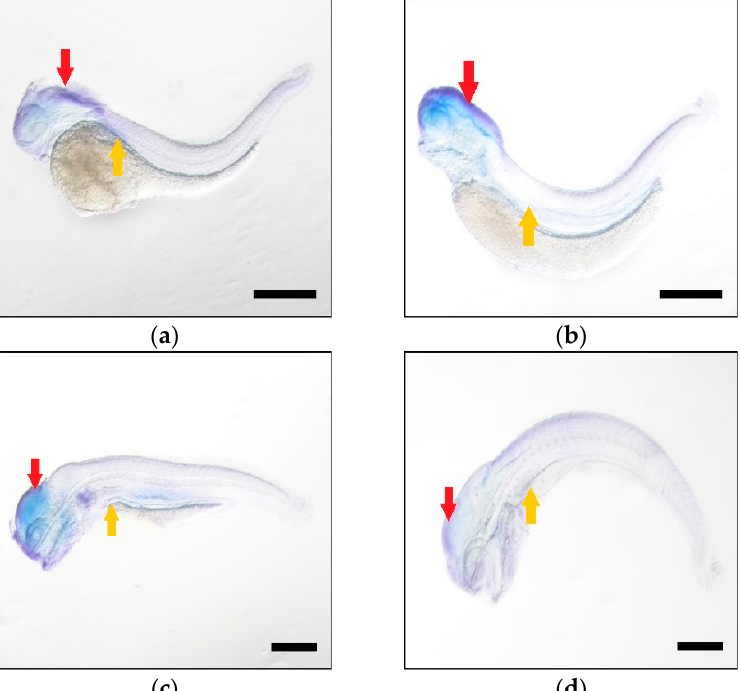
Figure 4. The tissue expressions of elovl5a during common carp larvae detected using WISH at 48 hpf ( a ), 72 hpf ( b ), 96 hpf ( c ) and 120 hpf ( d ). Larvae were hybridized with the probes and the blue dye represented the expression signal. Black scale bars: 500 μ m. The red arrow indicated the head region and the duct was marked with the yellow arrow.